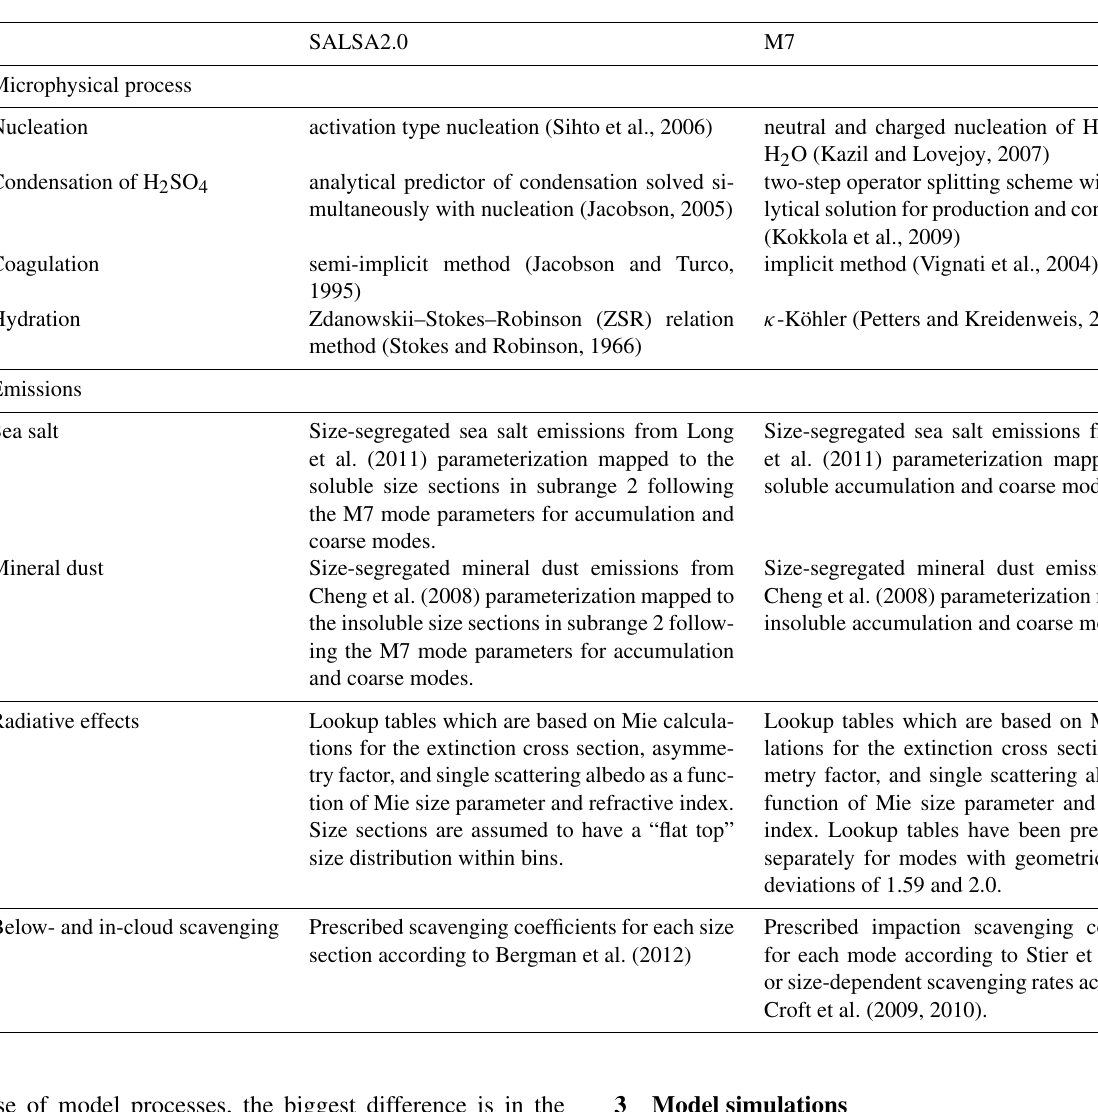
Table 1. Overview of the treatment of different aerosol processes in the sectional approach (SALSA) and the modal approach (M7) when using the default